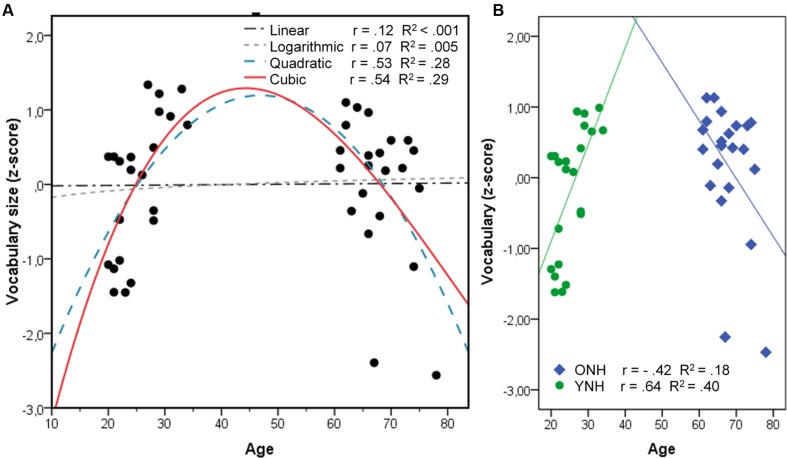
Correlations of vocabulary size and age in assuming a linear, logarithmic, quadratic, or cubic model fit over all data (A), and separate linear models for each group (B).